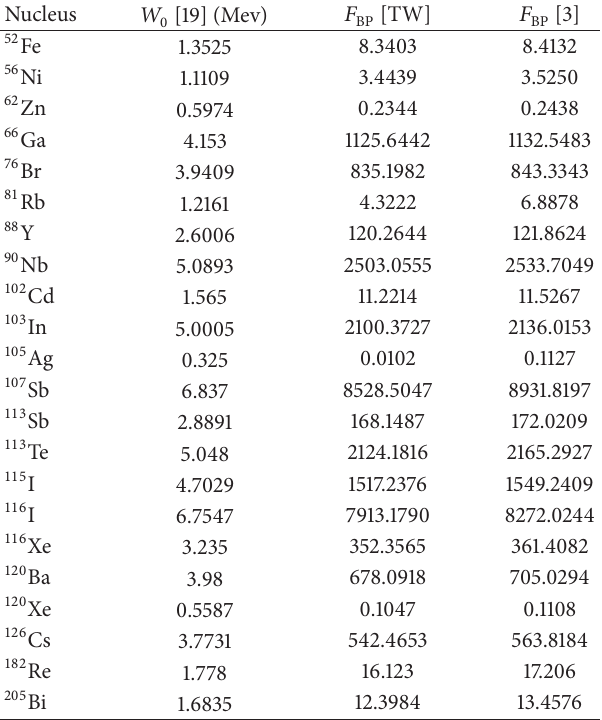
Table 2: Calculated phase space of 𝛽 + -decay (BP) for heavy nuclei compared with the ones we calculated using recipe of